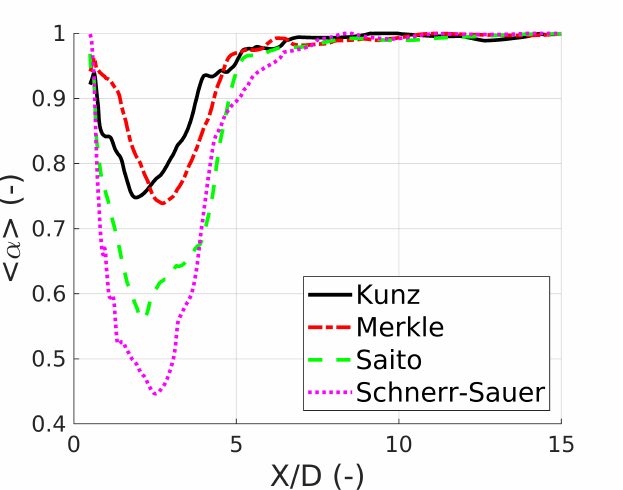
Figure 18. Mean liquid fraction downstream the cylinder along the centerline, results obtained considering analytical-based coefficients.